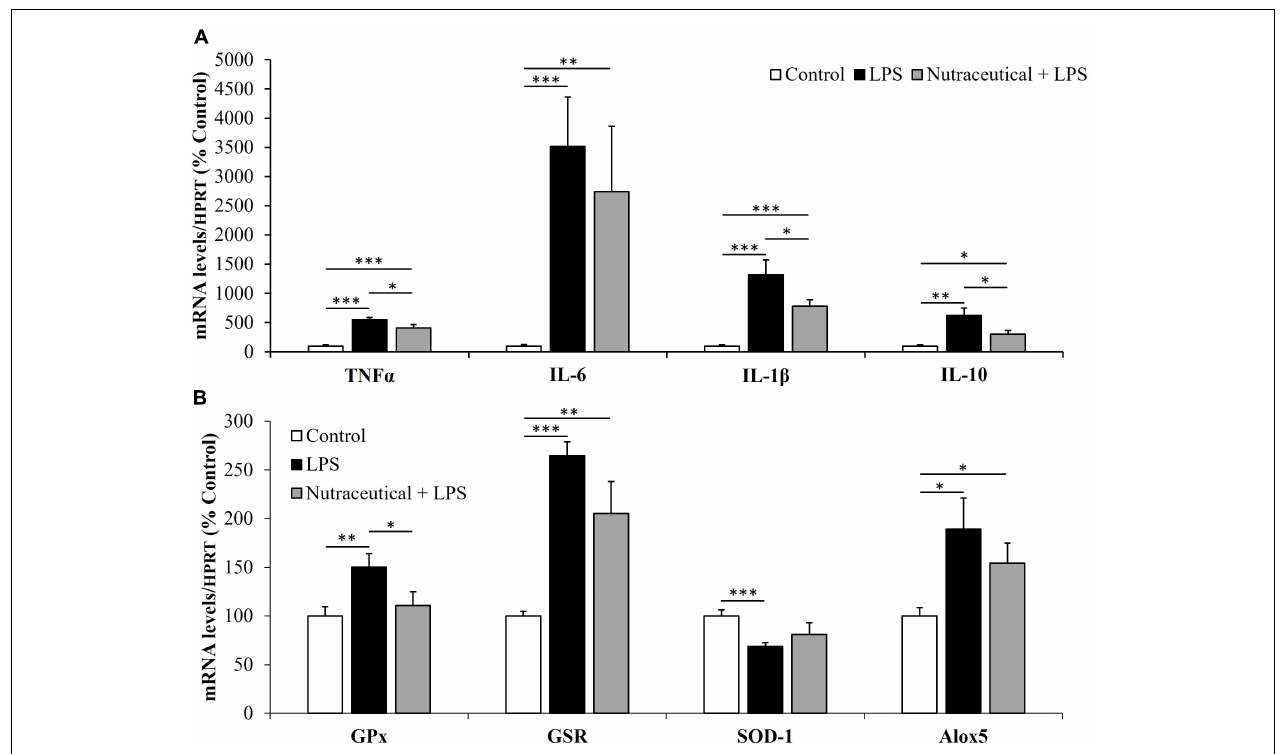
FIGURE 7 | mRNA concentrations of tumor necrosis factor α , Interleukin 6, Interleukin 1 β and Interleukin 10 (A) and Glutathione Peroxidase, Glutathione Reductase, Super Oxide Dismutase 1 and Lipoxygenase (B) in the gastrocnemius of rats treated with vehicle, LPS or LPS + Nutraceutical. Values are represented as mean ± SEM. ∗ p < 0.05; ∗∗ p < 0.01; ∗∗∗ p < 0.001.